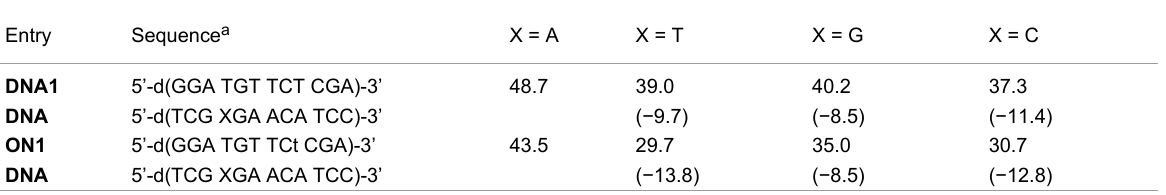
Table 4: T m data [°C] from UV-melting curves (260 nm) of ON1 in duplex with complementary mismatched DNA.